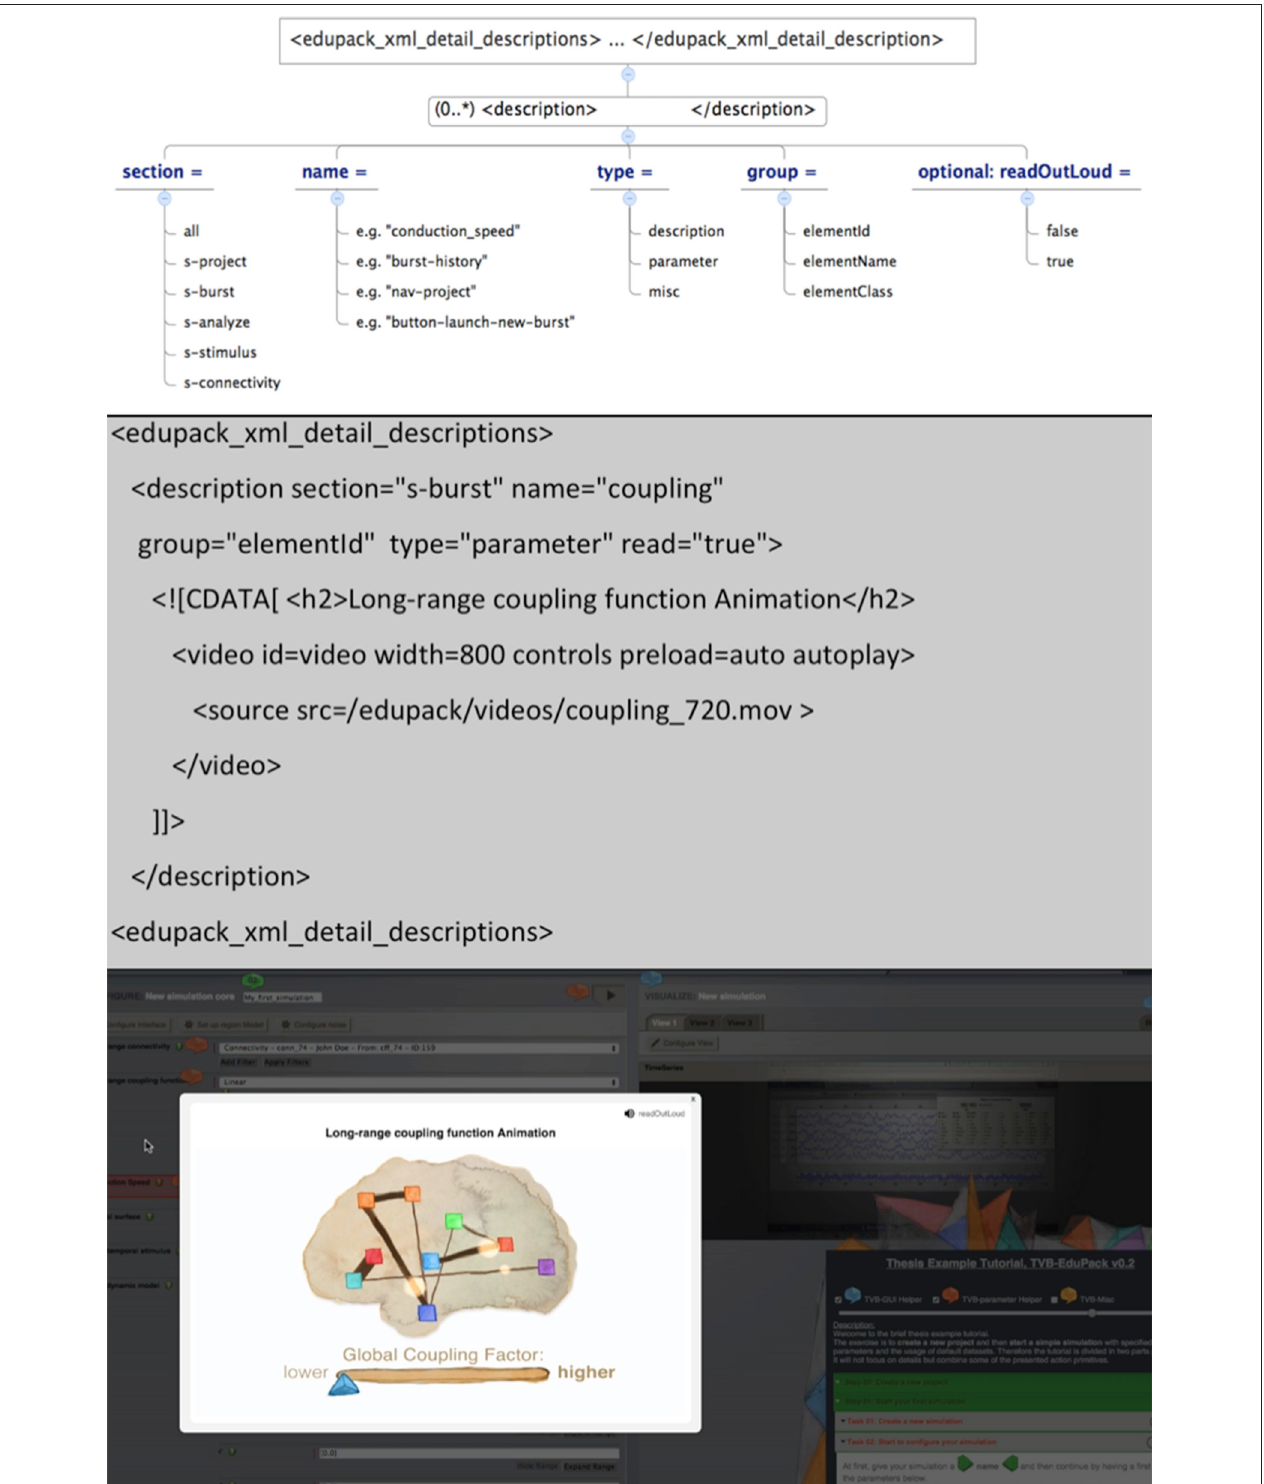
FIGURE 6 | Helper element XSD, exemplary code listing and resulting Helper element.